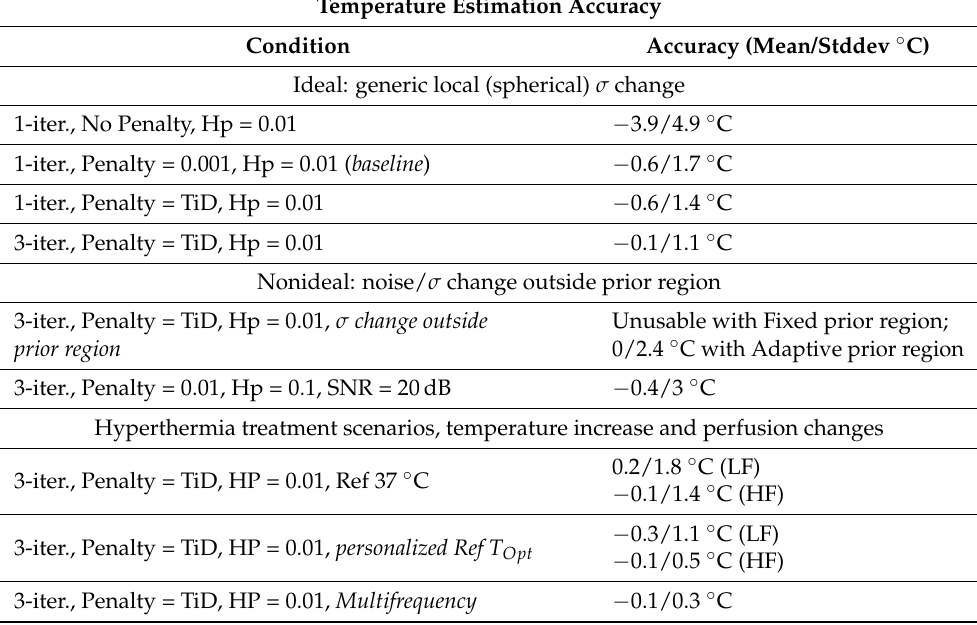
Table 3. Summary of the impact of the reconstruction approach (parameters, iterations, adaptive penalties and prior regions, reference model) and scenario (generic local σ change, detailed treat- ment scenario, perfusion changes, EIT frequency/frequencies) on the reconstruction accuracy (mean and standard deviation in the prior region). For the realistic HT therapy heating pattern scenarios, the worst case from the investigated Glenn and Duke scenarios is reported. Accuracy of nonpersonal- ized reconstruction scenarios is not reported here, since the chosen metrics are not